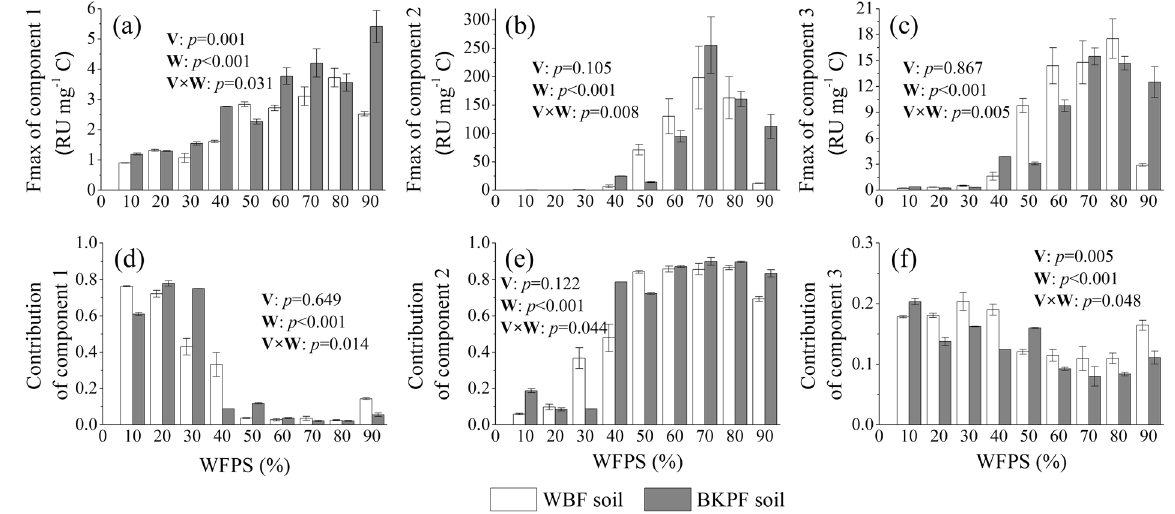
Figure 3. Effects of soil moisture on Fmax and contribution of three components in water extracts of thawing forest soils. Significant levels for the interactive effects of vegetation type (V) and soil WFPS (W) on each index are shown inside each sub-plot. Error bars reflect the standard error of Fmax and contribution of three components in soil water extracts between replicates, respectively ( n = 3 for all treatments).